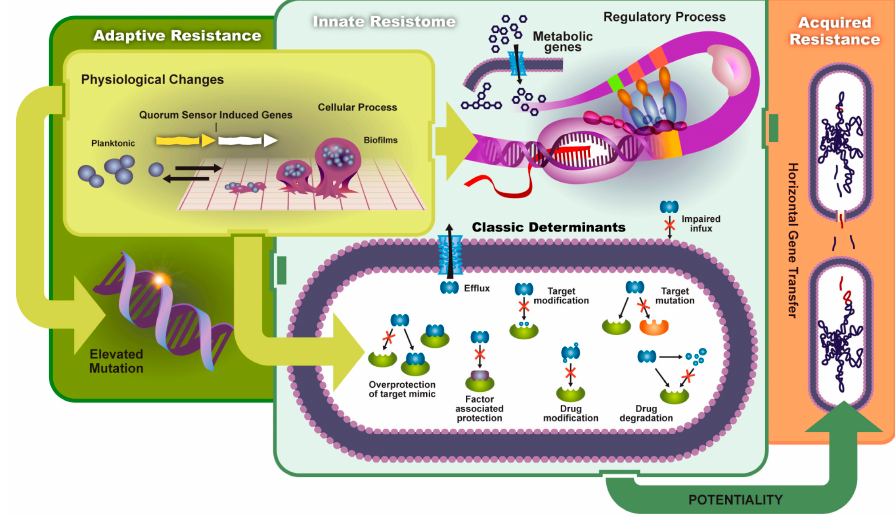
Figure 2. Pathways to antibiotic resistance via biofilm formation and quorum-sensing (QS) regulated gene transfer or innate resistance. Antibiotic resistance is caused by target mutation, drug efflux activation, drug modification, and uptake reduction. Reprinted with permission from [16]. Copyright 2017